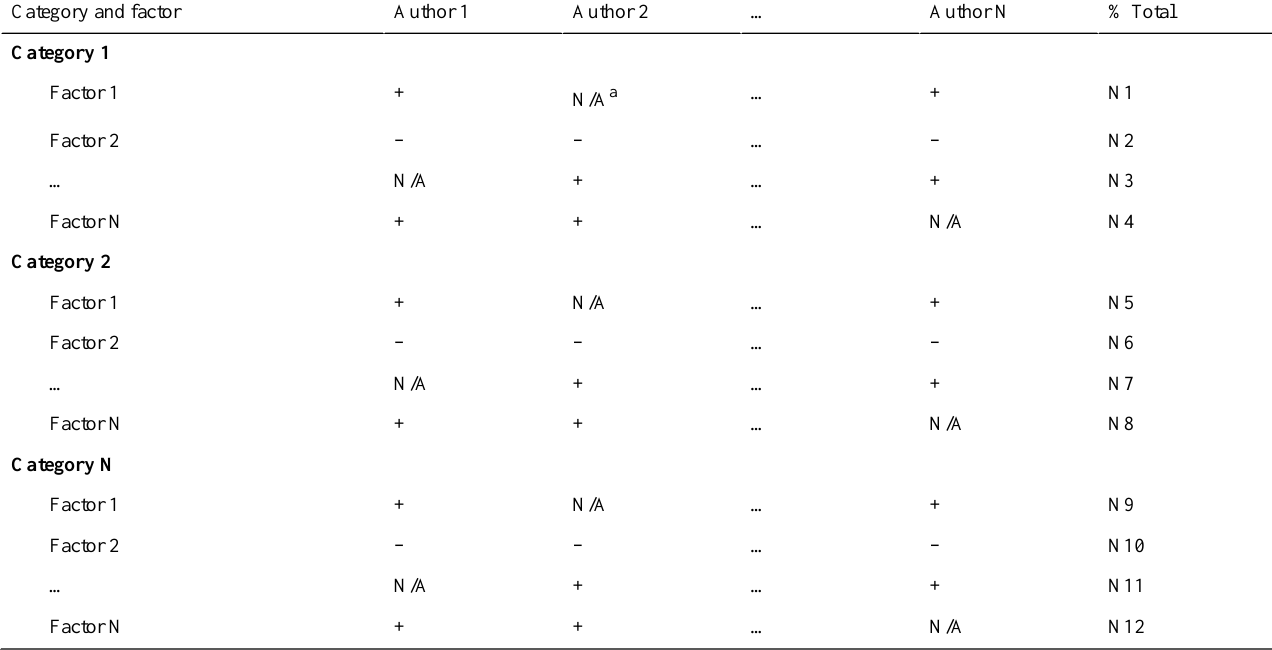
Table 2. Systematic tabulation of factors and barriers associated with contact tracing app adoption. A positive sign (+) indicates a facilitator and a negative sign (–) indicates a